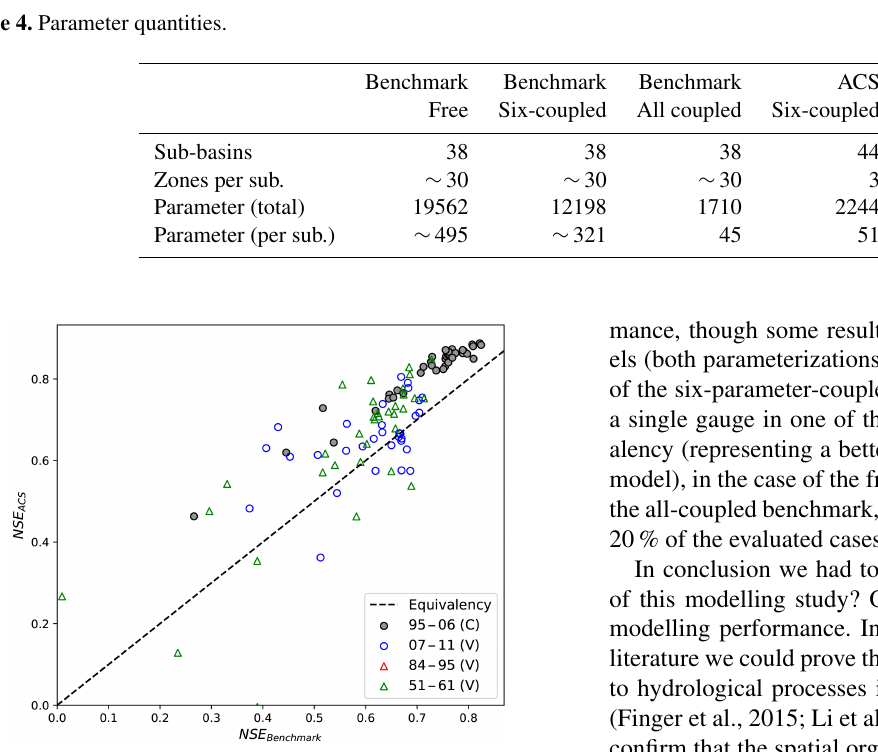
Figure 16. Nash–Sutcliffe efficiency of the ACS-based model and benchmark model; six coupled